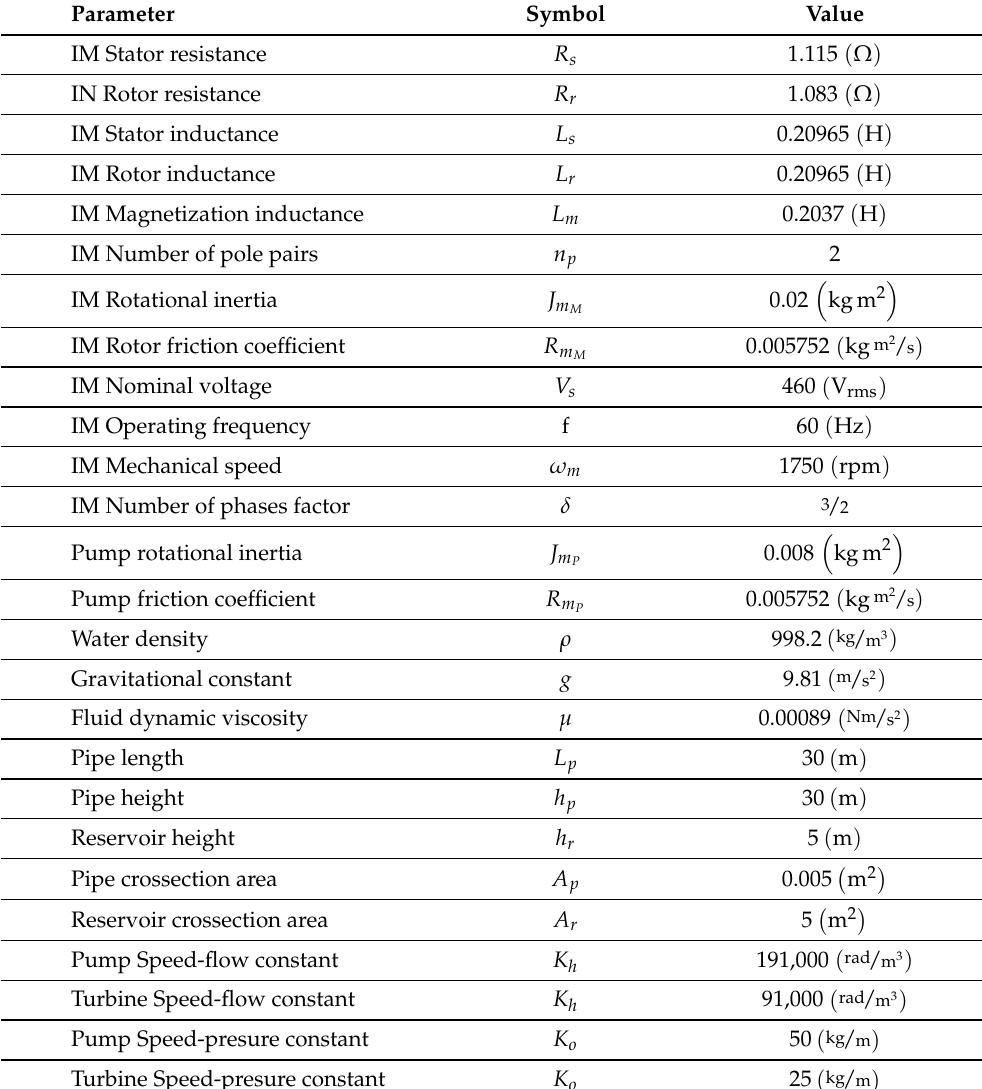
Table 1. Key parameters of the reversible hydropump–turbine